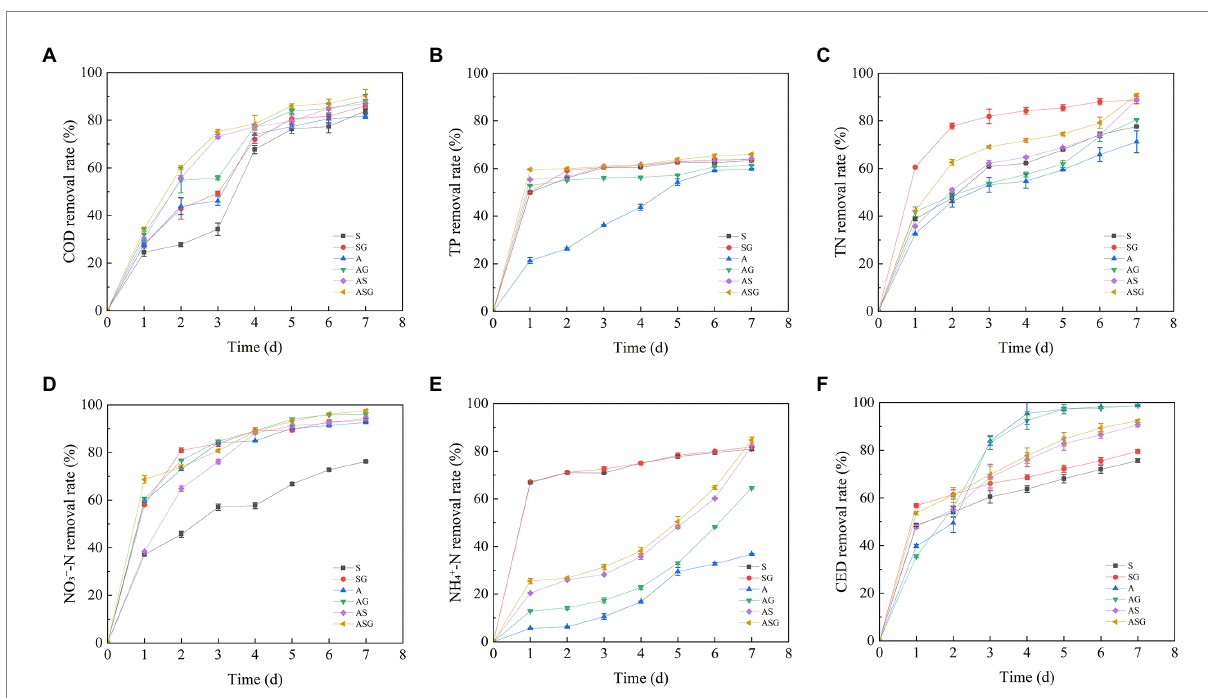
FIGURE 2 Dynamic changes in pollutants treatment efficiency of different microcosmic systems. (A) COD removal rate; (B) TP removal rate; (C) TN removal rate; (D) NO 3 − -N removal rate; (E) NH 4+ -N removal rate; (F) CED removal rate.